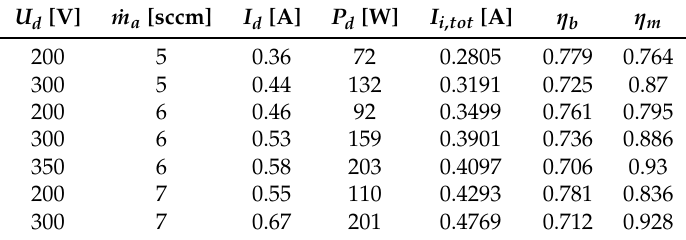
Table 5. Ion beam current for each investigated operating